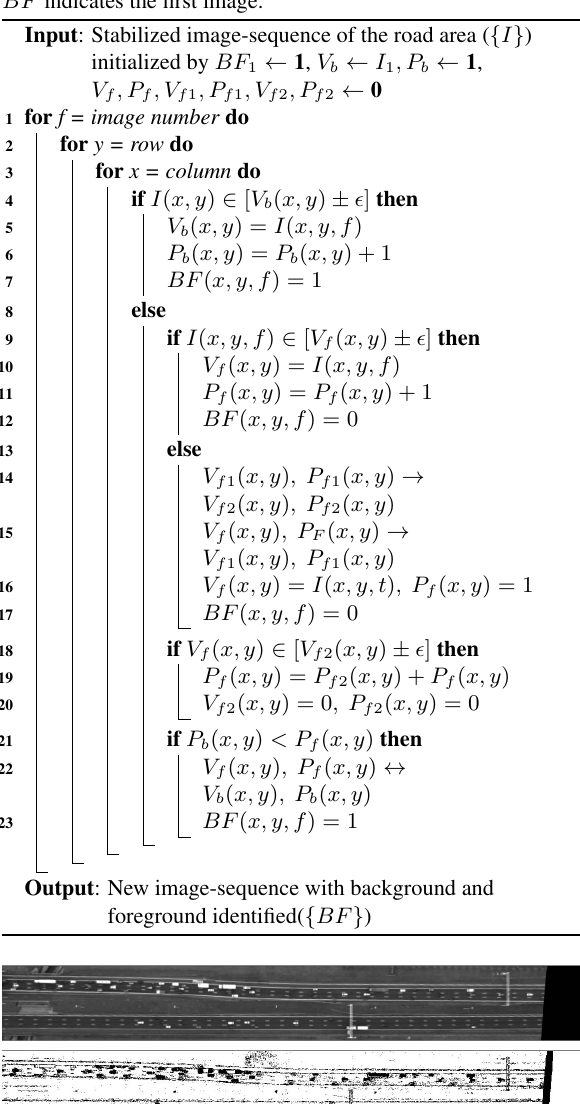
Algorithm 1: Near real-time foreground and background